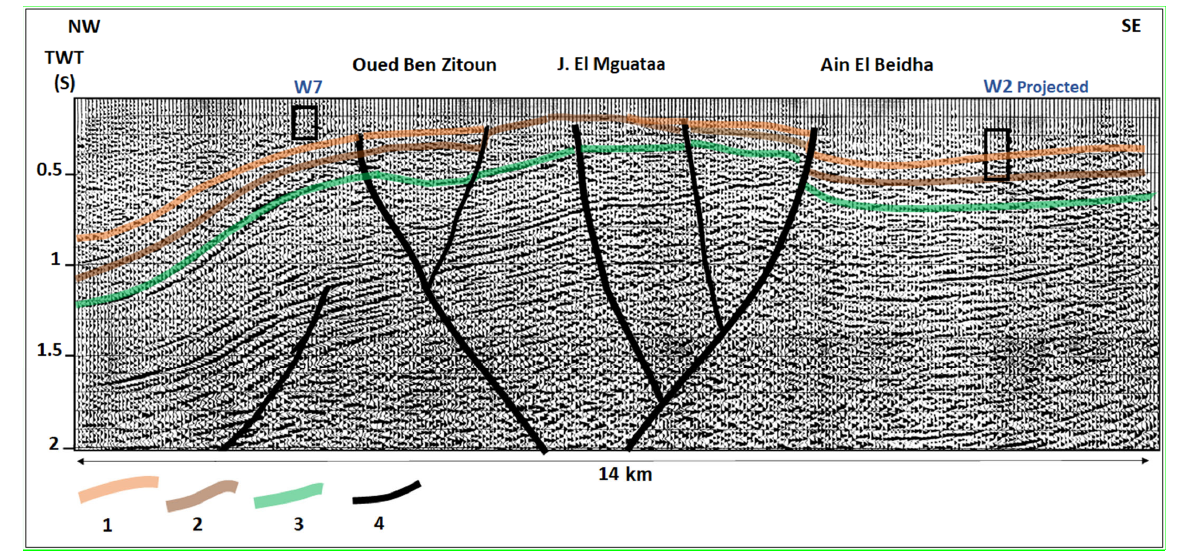
Figure 10. Interpreted seismic reflection profile L1. (1) Top. Oligocene. (2) Top. Eocene. (3) Top. Upper Cretaceous. (4) Major fault.